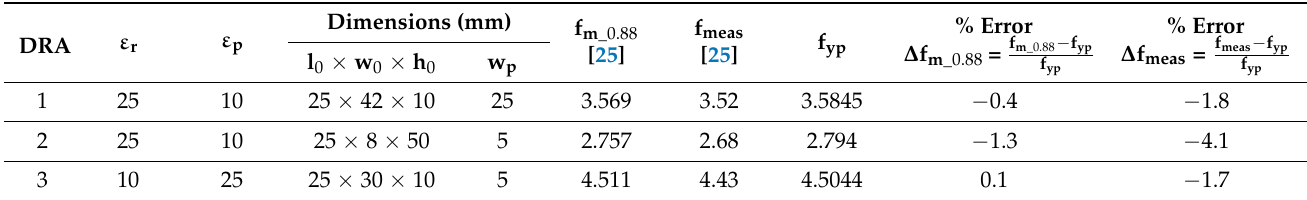
Table 2. Theoretical and experimental validation of the resonant frequency with Table 2 of [25] of a horizontally inhomoge- neous rectangular DRA.